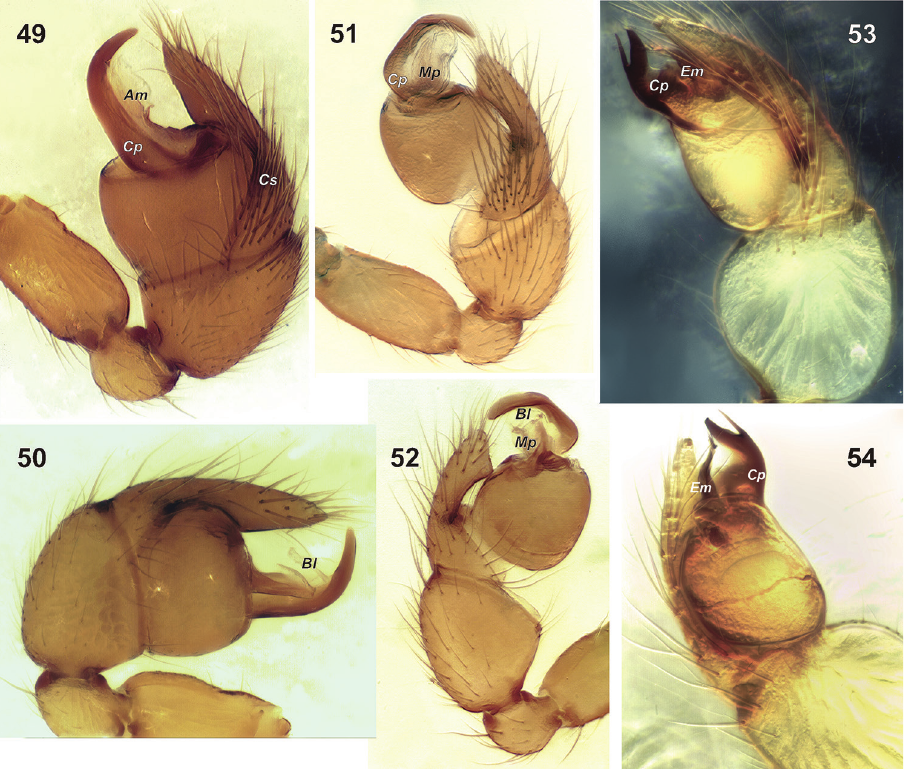
Figures 49–54. Male palp of Chedimanops eskovi sp. n. ( 49–50 ), C. rwenzorensis sp. n. ( 51–52 ) and Hybosidella etinde sp. n. ( 53–54 ). 49, 51, 53 retrolateral 50, 52, 54 prolateral. Abbreviations: Am ac- companying membrane; Bl barbed tip of accompanying membrane; Cp claw-shaped process; Em embolus; Mp membranous process. Legs : formula 1423. Leg cuticle smooth. Femur I moderately swollen; patella shorter than tibia, metatarsus short, tarsus short and dilated (Fig. 40). Tibia I subapi- cally and metatarsus I with dense prolateral scopula. Leg tarsi straight and ascopulate. Claw tufts weakly developed. Leg tarsi with two narrow and weakly dentate claws. Abdomen : ovoidal, slightly extended anteriorly and obtuse posteriorly. Abdominal scuta conforming a very short pedicel tube; dorsal portion of scutum with well-developed pos- terior margin. Epigastral scutum without lateral extensions. Postgastral lateral scuta ( PsL ) short and wide, median scuta indistinct (if present). AMS small, PMS and PLS not evident. Male palp : as in Figs 53–54, 64–66. Femur 2.5 times longer than wide; patella almost round, slightly thinner than femur. Tibia strongly swollen, almost as wide as long, approximately 2 times wider than femur, ventral length subequal to dorsal.